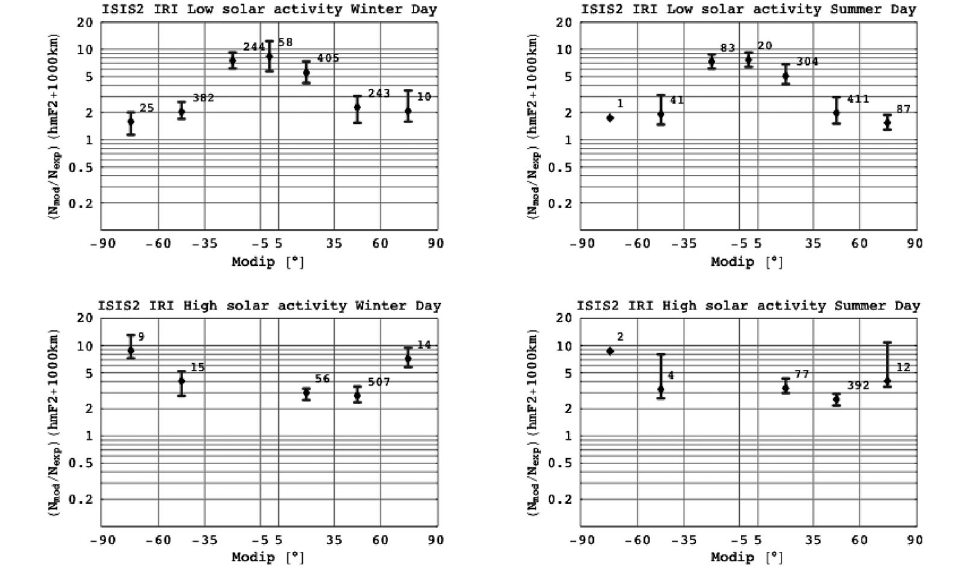
Fig. 18.16. Ratio between IRI and experimental electron density 1000 km above hmF 2. Numbers indicate the amount of data in each selection.